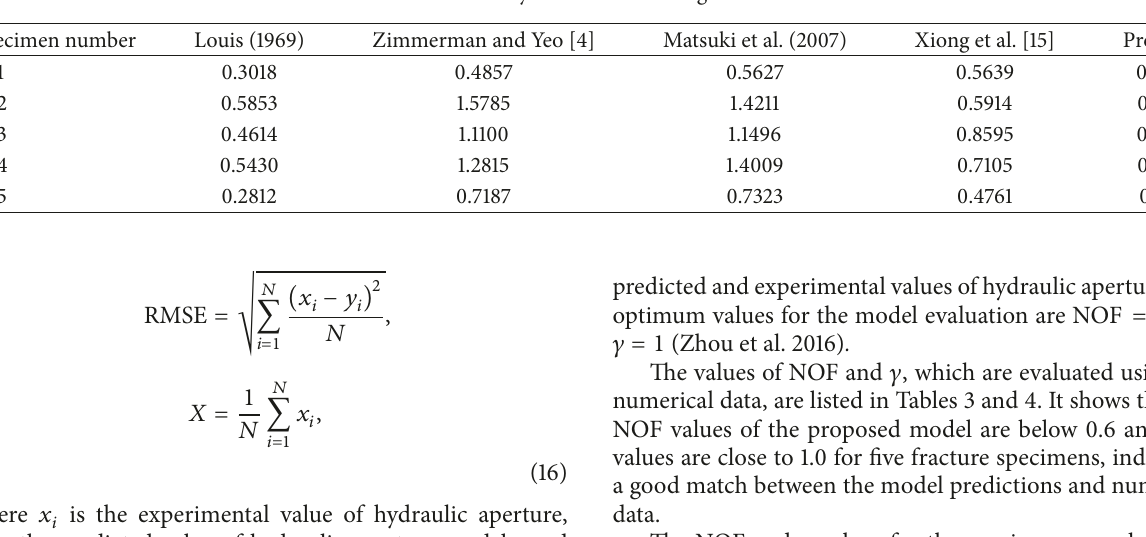
Figure 8: Velocity distribution ( 𝑦 direction) in the fracture Fr3 (unit: m/s) under different normal displacement: (a) 0.5 mm, (b) 0.8 mm, and (c) 1.0mm. Table 3: Evaluation of hydraulic model using the NOF